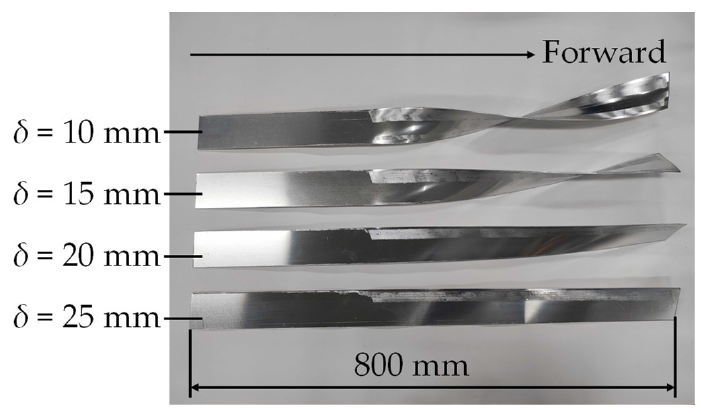
Figure 9. Effect of roll axial position on appearance of the rolled sheet metal. Table 6. Average specific twisted angle ( φ = 20°, t = 2 mm). Unit: °/mm.